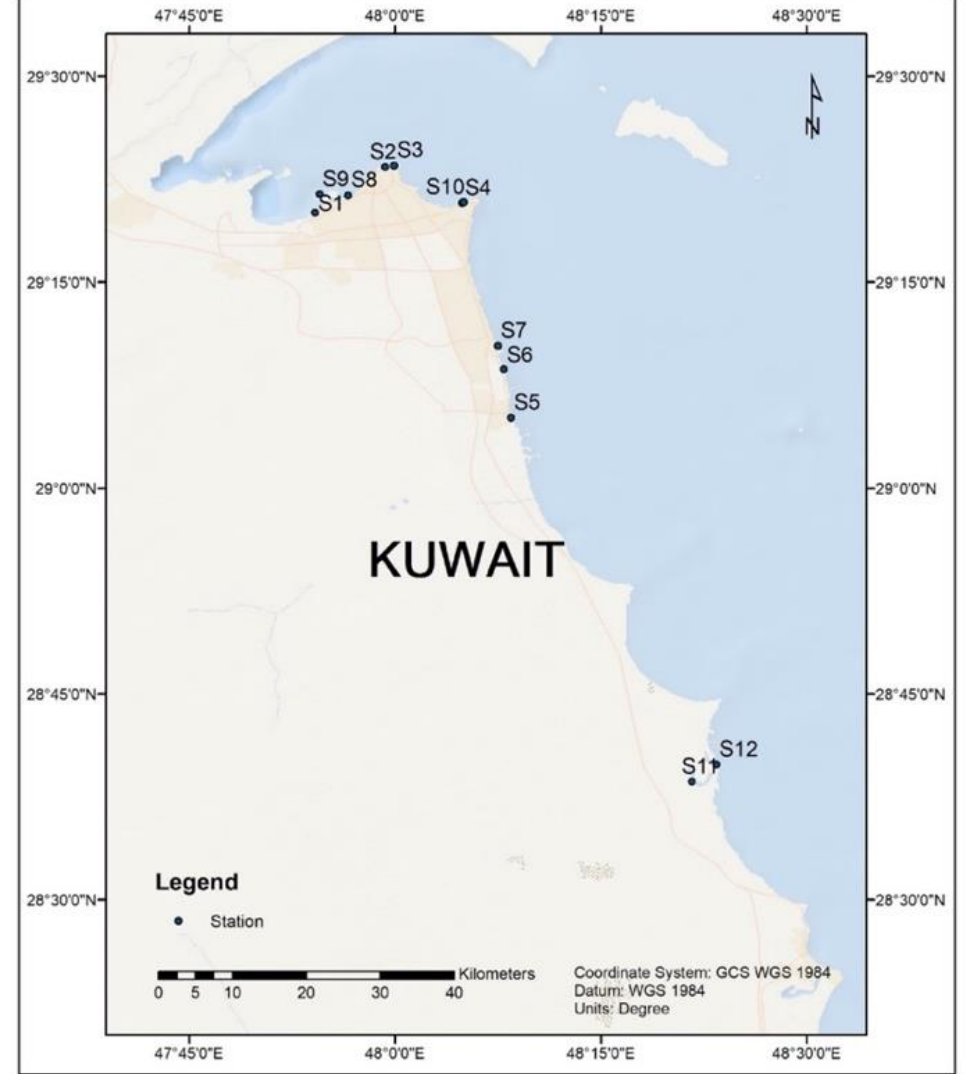
Figure 1. Sampling locations. The GPS coordinates of each location were plotted on Kuwait’s map based using the ArcGIS software v 10.4.1.